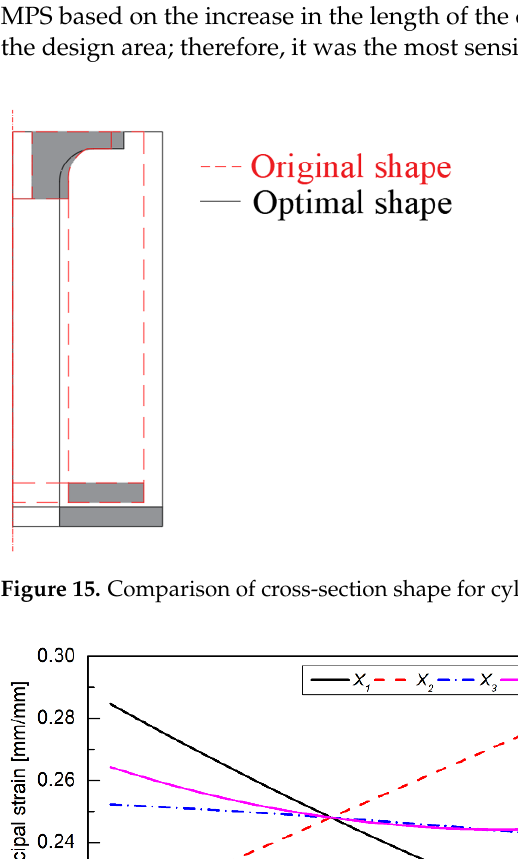
Table 7. Comparison of the sum of squared difference based on the optimization algorithm.